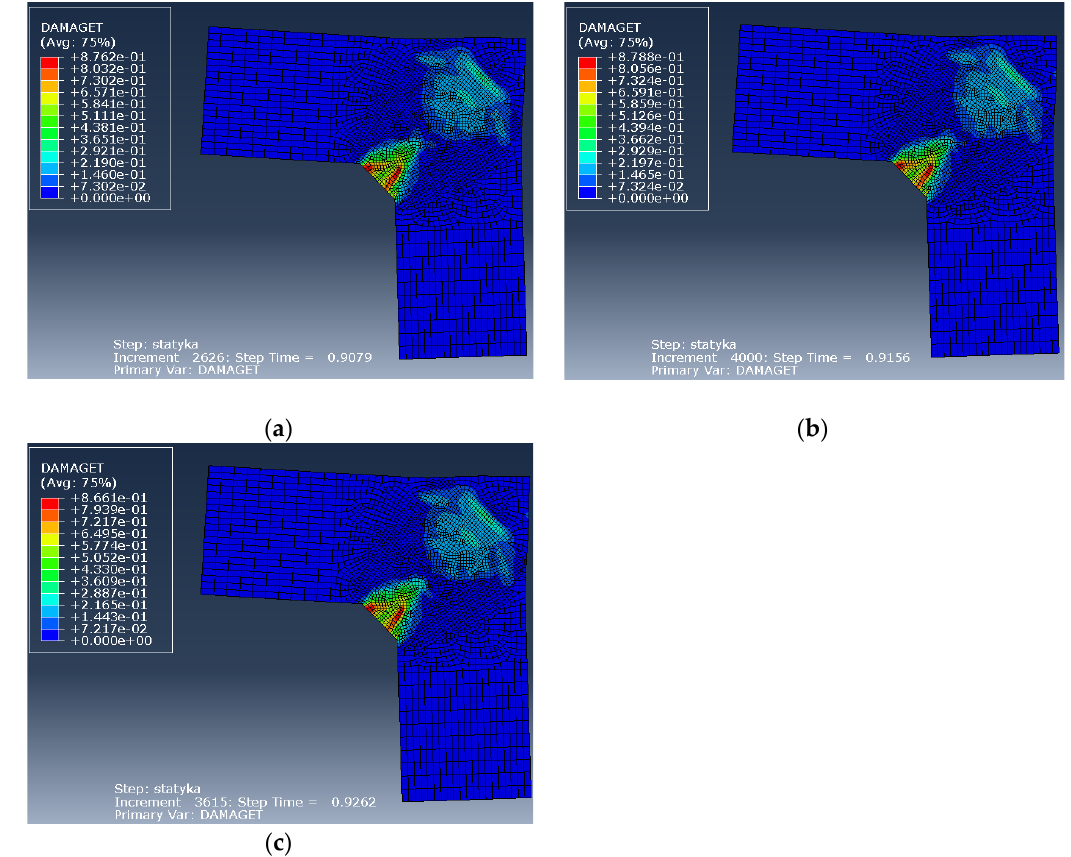
Figure 29. DAMAGET maps in the plane stress state for different areas of diagonal reinforcement: ( a ) 2 ϕ 8 mm, ( b ) 2 ϕ 12 mm, ( c ) 2 ϕ 16 mm bars.